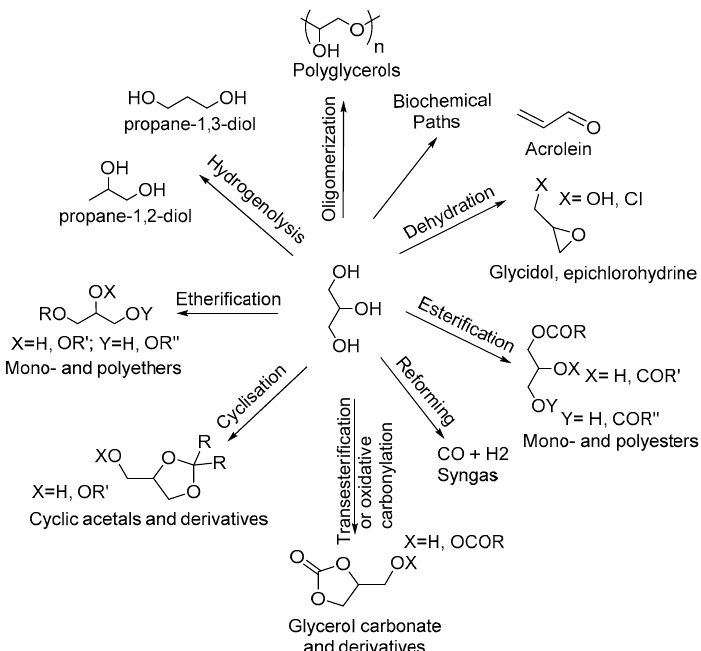
Figure 1. Glycerol conversion routes.